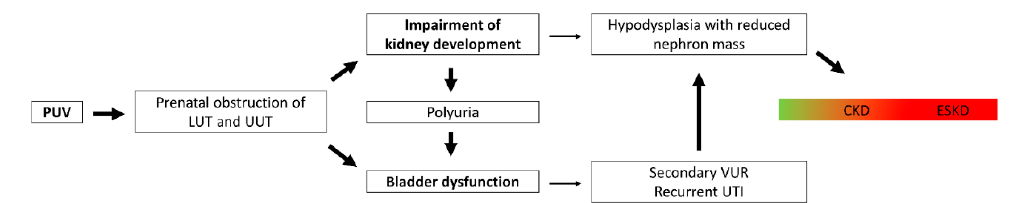
Figure 2. Pathophysiology of chronic kidney disease in patients with posterior urethral valves. Posterior urethral valves (PUV) lead to obstructions in the lower urinary tract (LUT) and the upper urinary tract (UUT), with consequent impairment of kidney development as well as bladder dys- function. Impairment in kidney development may result in hypodysplasia with a reduced nephron mass, and can therefore cause chronic kidney disease (CKD). CKD can progress to end-stage kidney disease (ESKD). Bladder dysfunction can be aggravated by polyuria of the impaired kidneys, and cause secondary vesicoureteral reflux (VUR) and recurrent urinary tract infections (UTI). The latter may cause parenchymal scars in the hypodysplastic kidneys and accelerate CKD progression.